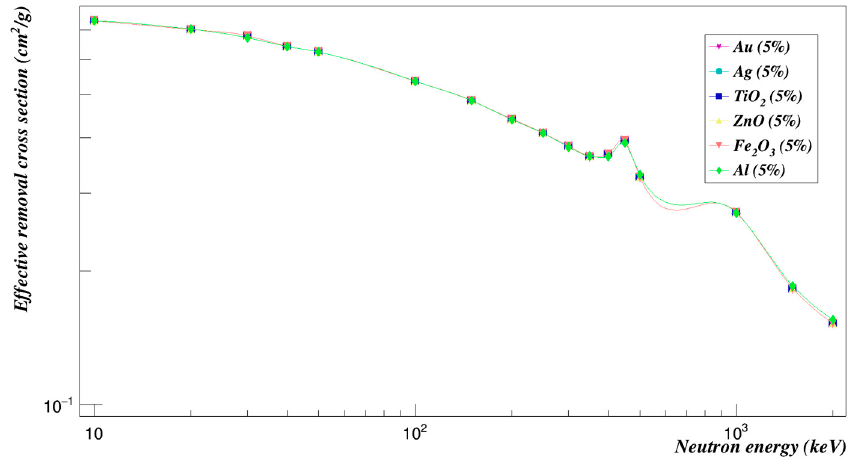
Figure 18. Effective removal cross sections of Polyimide doped with 5% of different Figure 18. E ff ective removal cross sections of Polyimide doped with 5% of di ff erent composites.